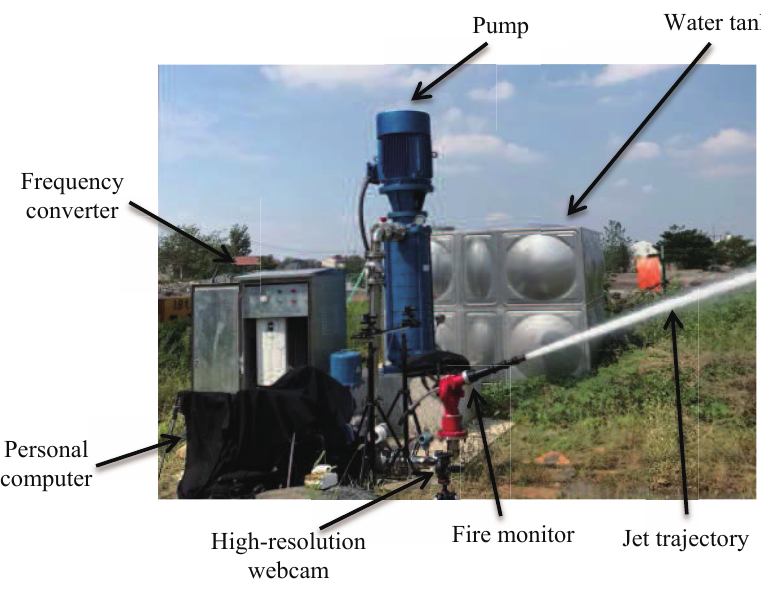
Figure 8. The experiment platform of the NFCV